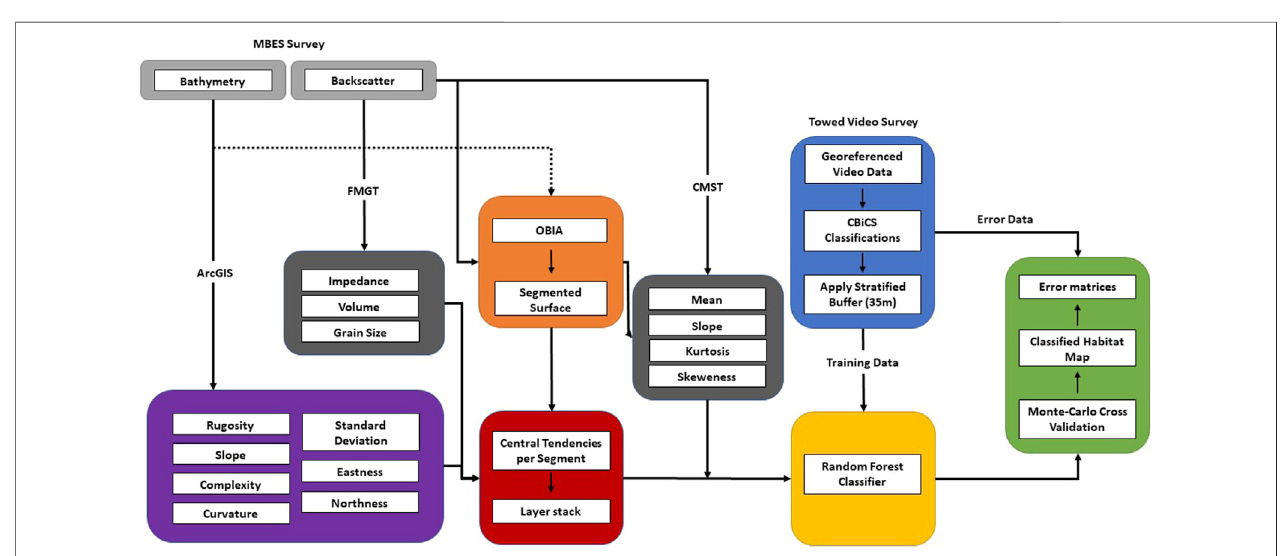
Frontiers in Remote Sensing |